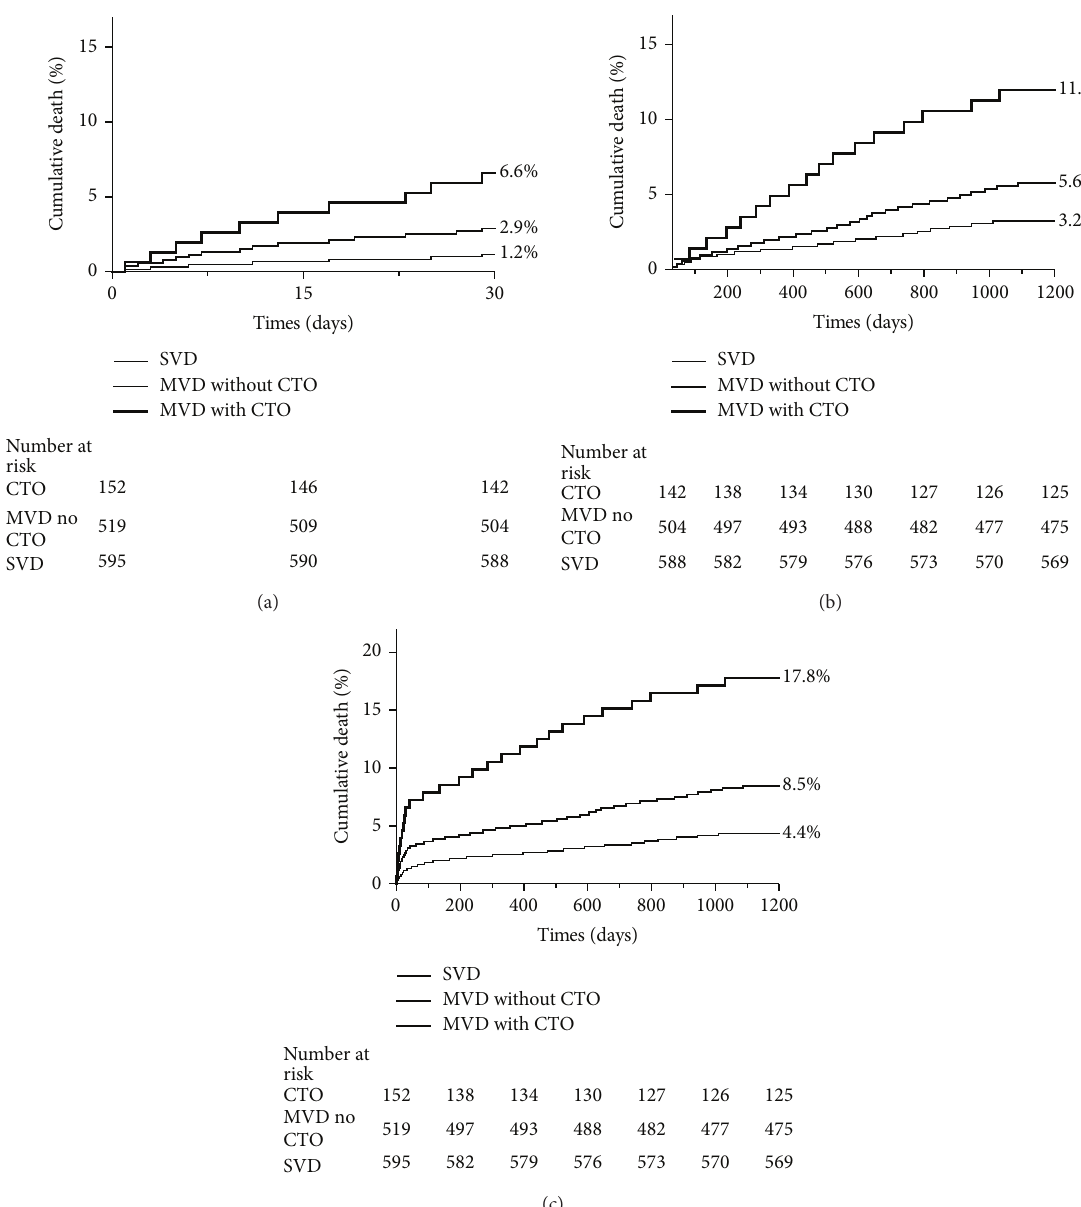
Figure 1: Time-to-event curves for mortality 0 to 30 days (a), mortality 30 days–3 years (b), and overall 3-year mortality (c) in patients with SVD, MVD without a CTO, and MVD with a CTO in a non-IRA. 𝑃 values shown in figure are three-way. Pair-wise 𝑃 values for 30-day mortality are CTO versus SVD, 𝑃 < 0.001 ; MVD without a CTO versus SVD, 𝑃 = 0.040 ; CTO versus MVD without a CTO, 𝑃 = 0.035 . Pair-wise 𝑃 values for mortality between 30 days and 3 years are CTO versus SVD, 𝑃 < 0.001 ; MVD without a CTO versus SVD, 𝑃 = 0.043 ; CTO versus MVD without a CTO, 𝑃 = 0.011 . Pair-wise 𝑃 values for overall 3-year mortality are CTO versus SVD, 𝑃 < 0.001 ; MVD without a CTO versus SVD, 𝑃 = 0.005 ; CTO versus MVD without a CTO, 𝑃 = 0.001